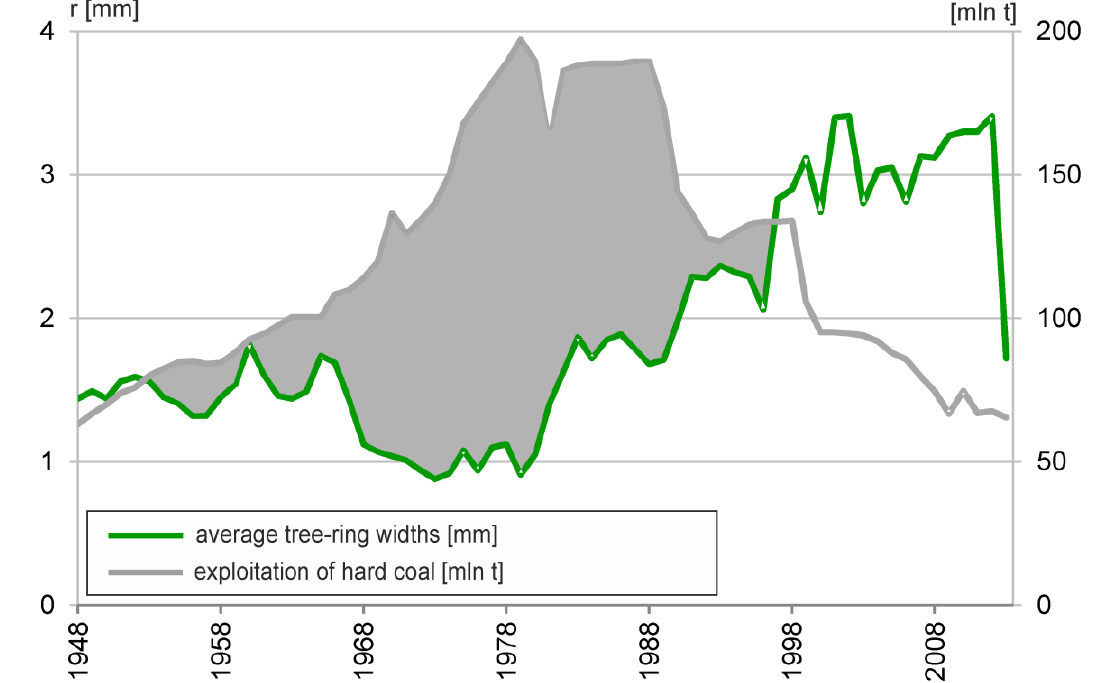
Fig. 5. Average tree-ring widths in firs at the study site in the Beskid Niski Mountains from the mid-20th century compared to hard coal production levels in the Upper Silesian Industrial Region (source data from Malik et al., 2012). Periods of inverse proportionality are marked by a grey